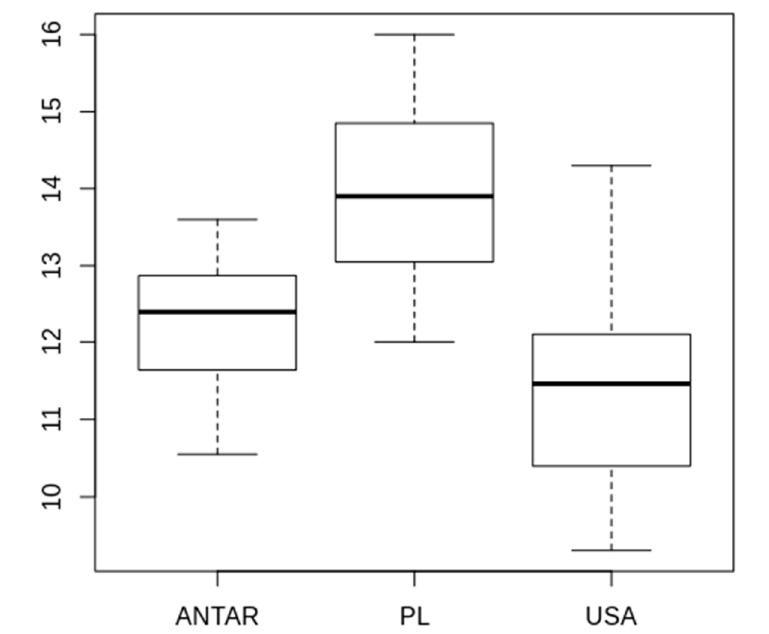
Figure 12. Differences in the egg processes height between the studied populations of Paramacrobiotus fairbanksi Schill, Förster, Dandekar and Wolf [25] (Antar, Antarctic; PL, Poland; USA, USA). Minimum, maximum, median, first quartile, and third quartile for each population are presented.